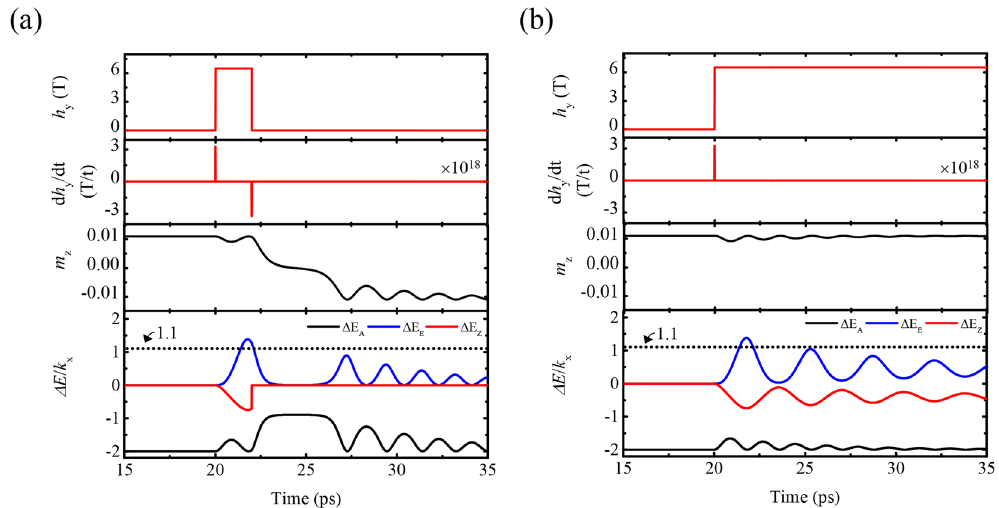
Figure 3. Energetic analysis for switching mode and non-switching mode using two different magnetic fields in canted antiferromagnets. The differential fields, d h y /dt in two dynamic modes are of single-cycle ( a ) and half-cycle ( b ) forms. Three energy differences (exchange, anisotropy and Zeeman energies) are plotted as Δ E E = 2 J [ s 1 (t) · s